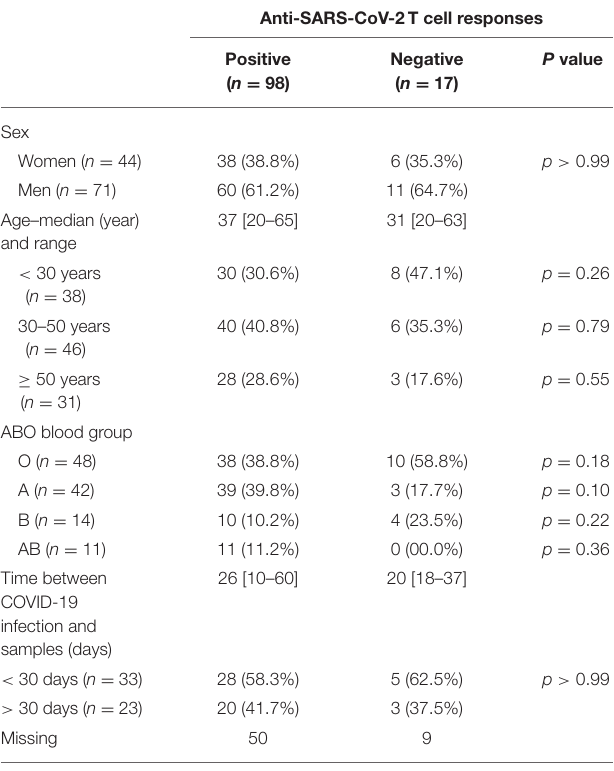
TABLE 2 | Distribution of anti-SARS-CoV-2T cell responses according to convalescent plasma donors’ characteristics. Anti-SARS-CoV-2T cell